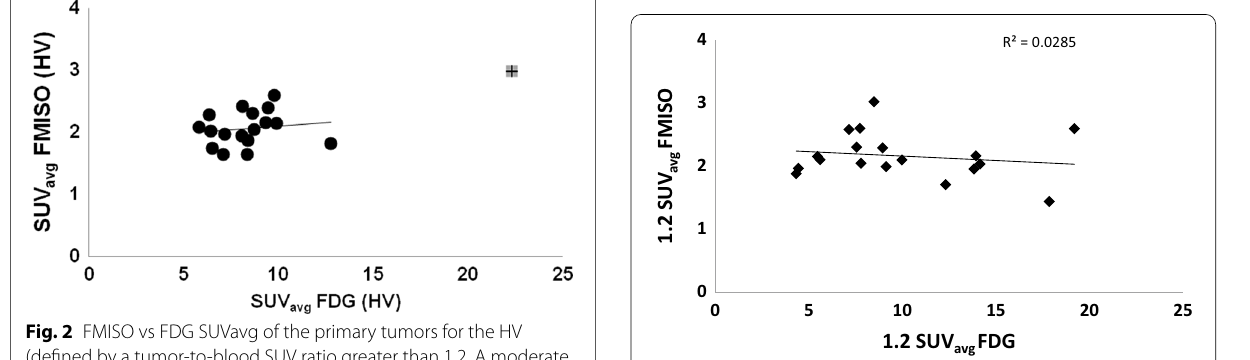
Fig. 3 FMISO vs FDG SUVavg of the Lymph Nodes for the HV (defined by a tumor-to-blood SUV ratio greater than 1.2. A weak Pearson correlation, R 0.17 (paired t test, P < 0.01), is shown between the =